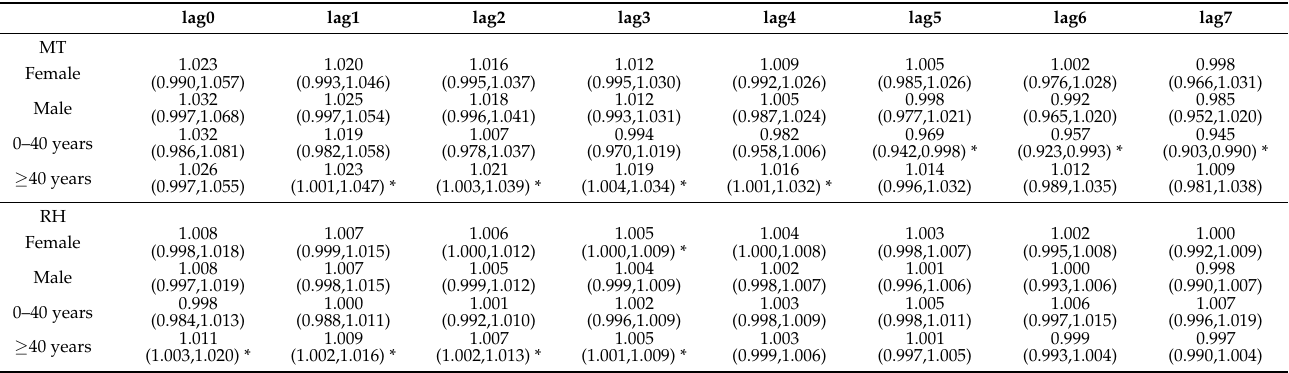
Table 2. The relative risk of the 75th percentile of ambient temperature and relative humidity on HZ outpatients in Hefei.